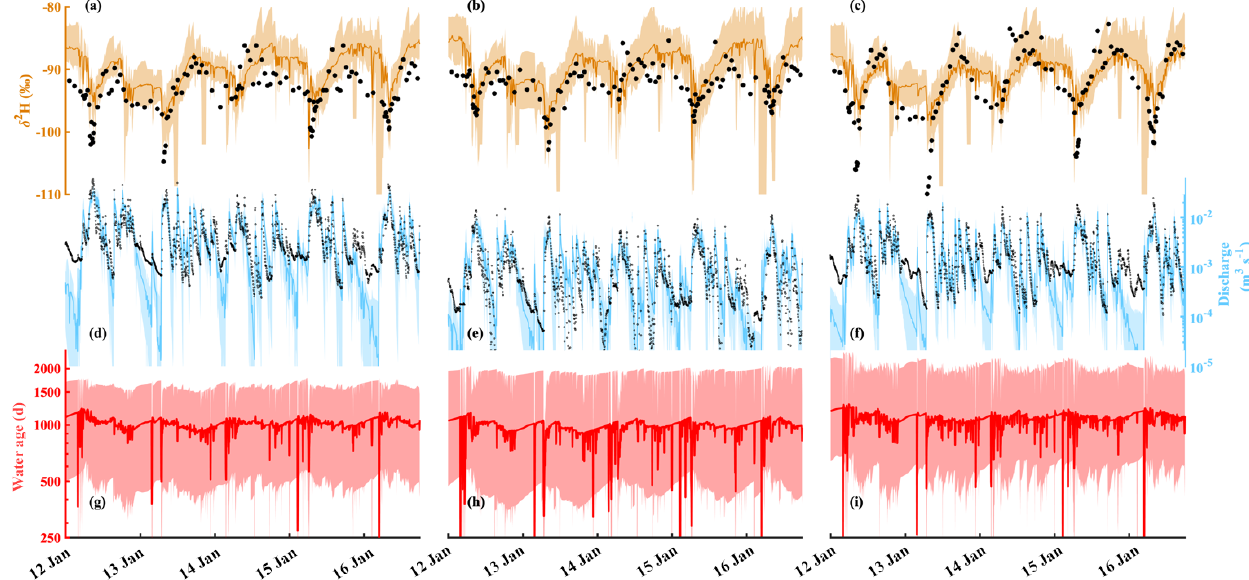
Figure 2. Calibration 95% maximum and 5% minimum bounds, median simulation (solid line), and measured data (black circles) of δ 2 H for (a) C7, (b) C2, and (c) C4; discharge for (d) C7, (e) C2, and (f) C4; and stream water age for (g) C7, (h) C2, and (i) C4.